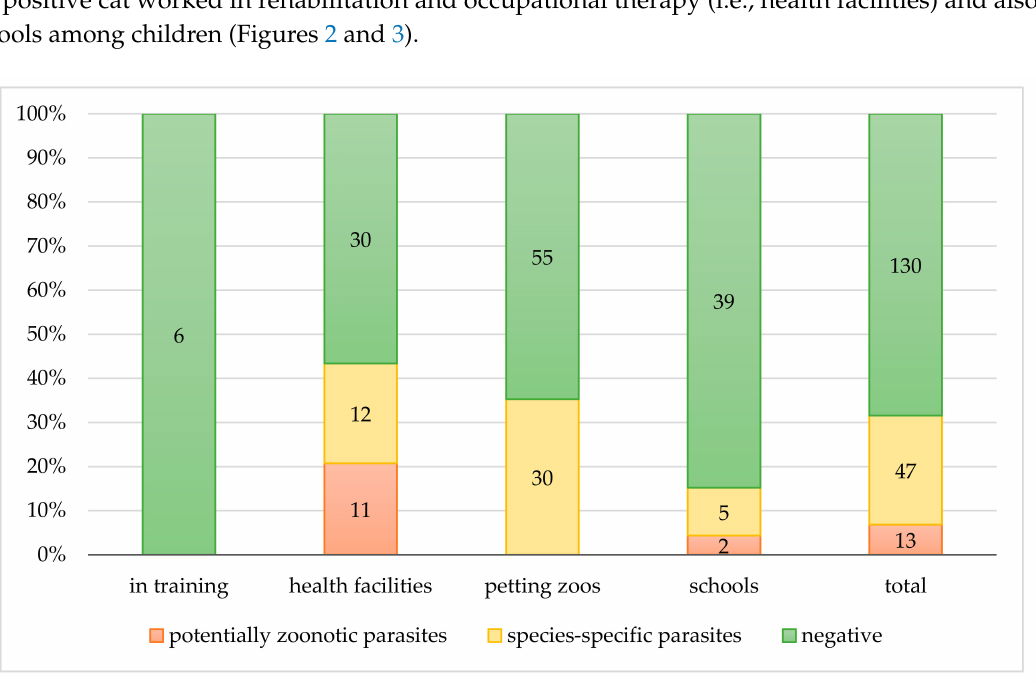
Figure 2. Copromicroscopic results. Distribution of negative and positive (zoonotic and species-specific) results among the contexts of the AAIs.